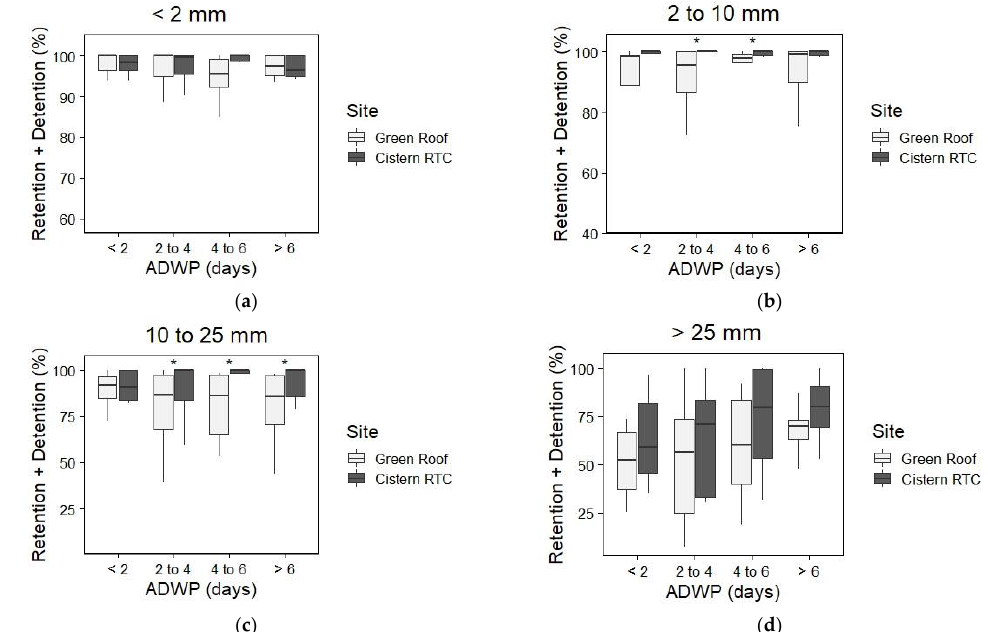
Figure 1. Total on-site retention + detention for different storm sizes ( a – d ) and antecedent dry- weather periods (ADWPs). Green Roof denotes retention calculated with the green-roof runoff alone (Equation (1)). Cistern RTC denotes total onsite green roof retention + cistern detention (Equation (2)). The * at the top denotes groups where the difference between Cistern RTC and Green Roof was statistically significant ( p < 0.05). Water 2022 , 14 , x FOR PEER REVIEW